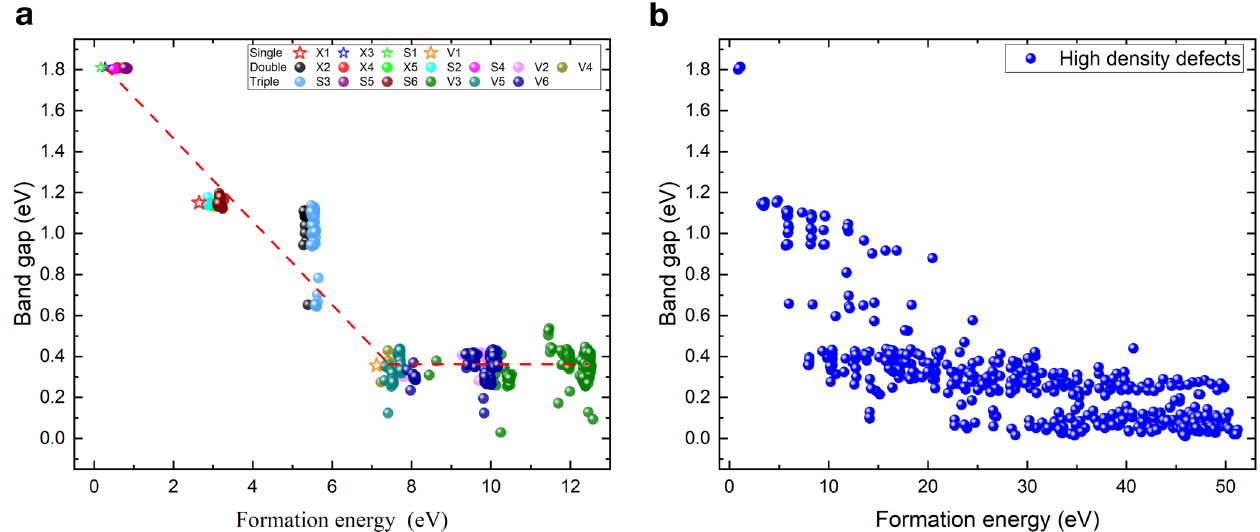
Fig. 2 The binary property (band gap vs. formation energy) map of defects in MoS 2 . The property maps for a simple defects and b high- density defects. The band gap is calculated as the separation between HOMO and LUMO. The data for each defect type are color-coded and the dashed line is a guide for the eyes in ( a ).